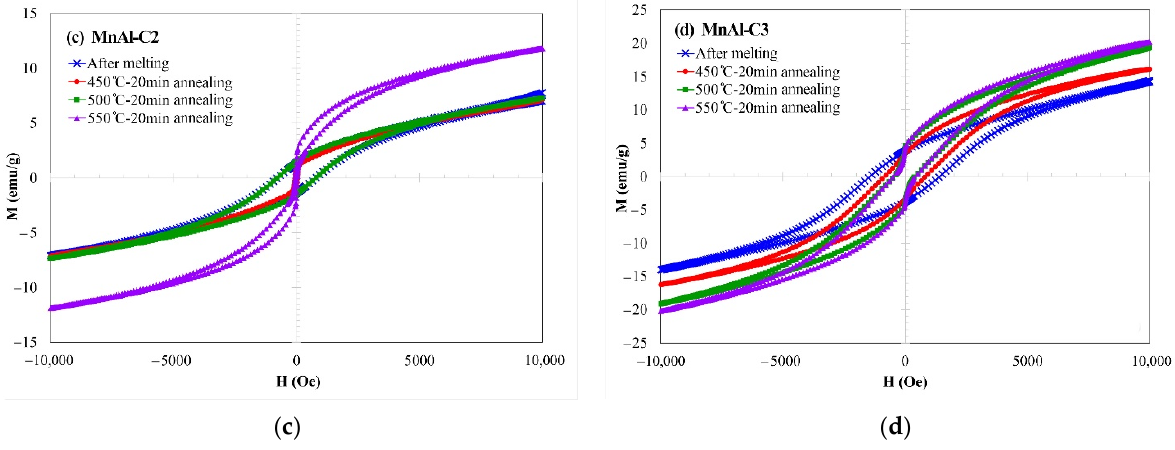
Figure 3. Hysteresis loops of (Mn 55 Al 45 ) 100-x C x powders; ( a ) MnAl–C0 (x = 0), ( b ) MnAl–C1 (x = 1), ( c ) MnAl–C2 (x = 2), and ( d ) MnAl–C3 (x = 3) after melting and annealing at 450, 500, and 550 °C for 20 min under argon atmosphere.